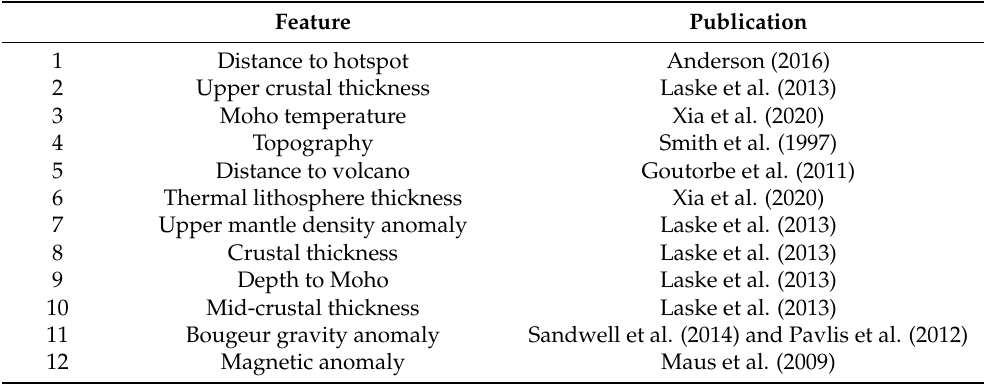
Table 1. The geophysical and geological features used in this study with their respective sources.